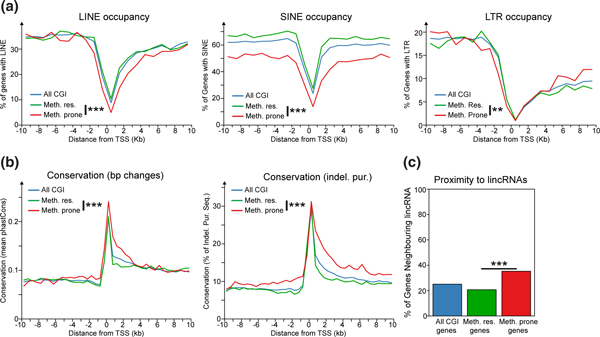
Hypermethylated genes have conserved promoter regions. (a) Hypermethylation prone promoters are depleted of repetitive elements. Shown are graphs of the frequency of LINEs, SINEs and LTRs at 1 kb intervals around hypermethylation prone and resistant TSSs. The significance of the differences in densities observed at prone and resistant genes were determined using Fisher's exact tests for the repeat counts ± 2 kb from the TSSs (*** P < 0.001, ** P < 0.01 and * P < 0.05). (b) Hypermethylation prone promoter regions are evolutionarily conserved. Shown are graphs of the level of conservation found in 500bp intervals around hypermethylation prone and resistant TSSs. Conservation was assessed through two different methods: one measuring the rate of basepair substitutions between species, 'bp Changes' [46], and the other measuring the rate of insertions and deletions between species, 'Indel. Pur.' [47]. The significance of observed differences between hypermethylation-prone and -resistant genes was assessed using a Wilcoxon rank sum test for the scores ± 2 kb from the TSSs. (c) Hypermethylation prone genes are found adjacent to lincRNAs. Shown is a chart of the percent of hypermethylation-prone and -resistant genes found neighboring a lincRNA [49]. The significance of differences between the gene sets was assessed using Fisher's exact tests. lincRNA, long intergenic non-coding RNAs; LTR, long terminal repeat; TSSs, transcriptional start sites.